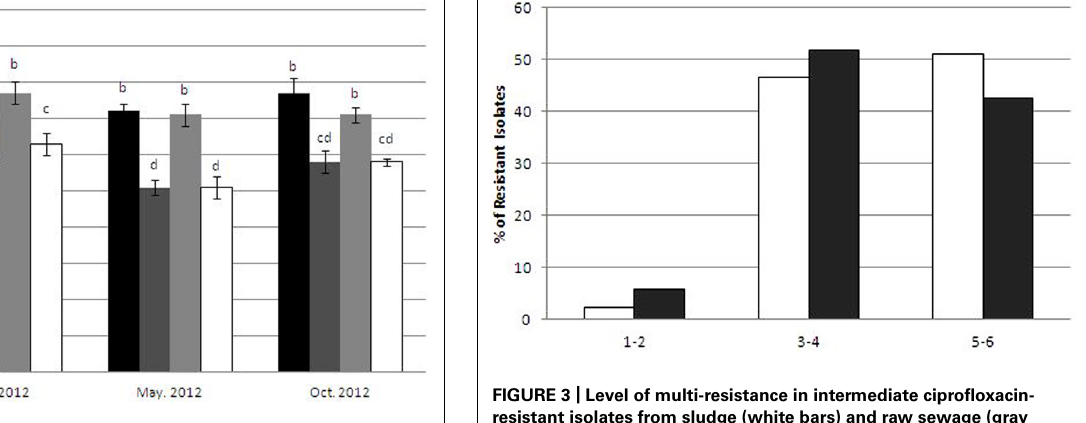
FIGURE 1 |Abundance of Enterobacteriaceae in dewatered sludge: non-selective media (black bars) and 0.4 μ g/ml ciprofloxacin-amended media (dark gray bars); and in raw sewage: non-selective media (light gray bars), and 0.4 μ g/ml ciprofloxacin-amended media (white bars). Error bars indicate standard deviation. Mean values that do not share any letters are considered significantly different (Tukey’s HSD p < 0.05).